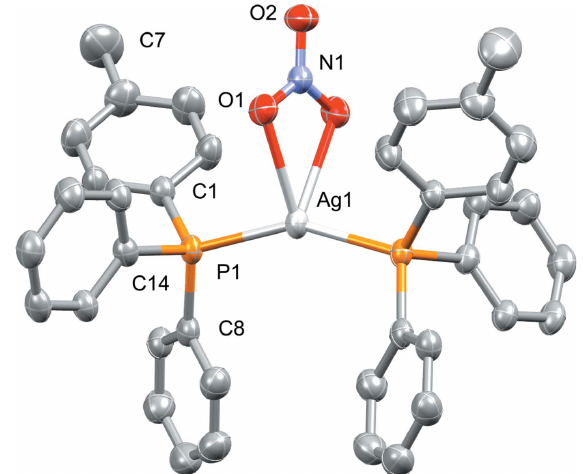
Figure 1 Perspective view of the molecular structure of the title compound showing thermal displacement ellipsoids at the 50% probability level. Hydrogen atoms are omitted for clarity. Unlabelled atoms are related by a twofold axis of